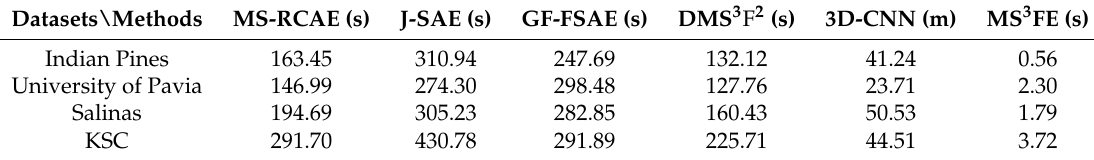
Figure 12. Classification maps of the KSC dataset obtained by different methods (AA). Table 5. Execution Time of Different Methods on the Four Data